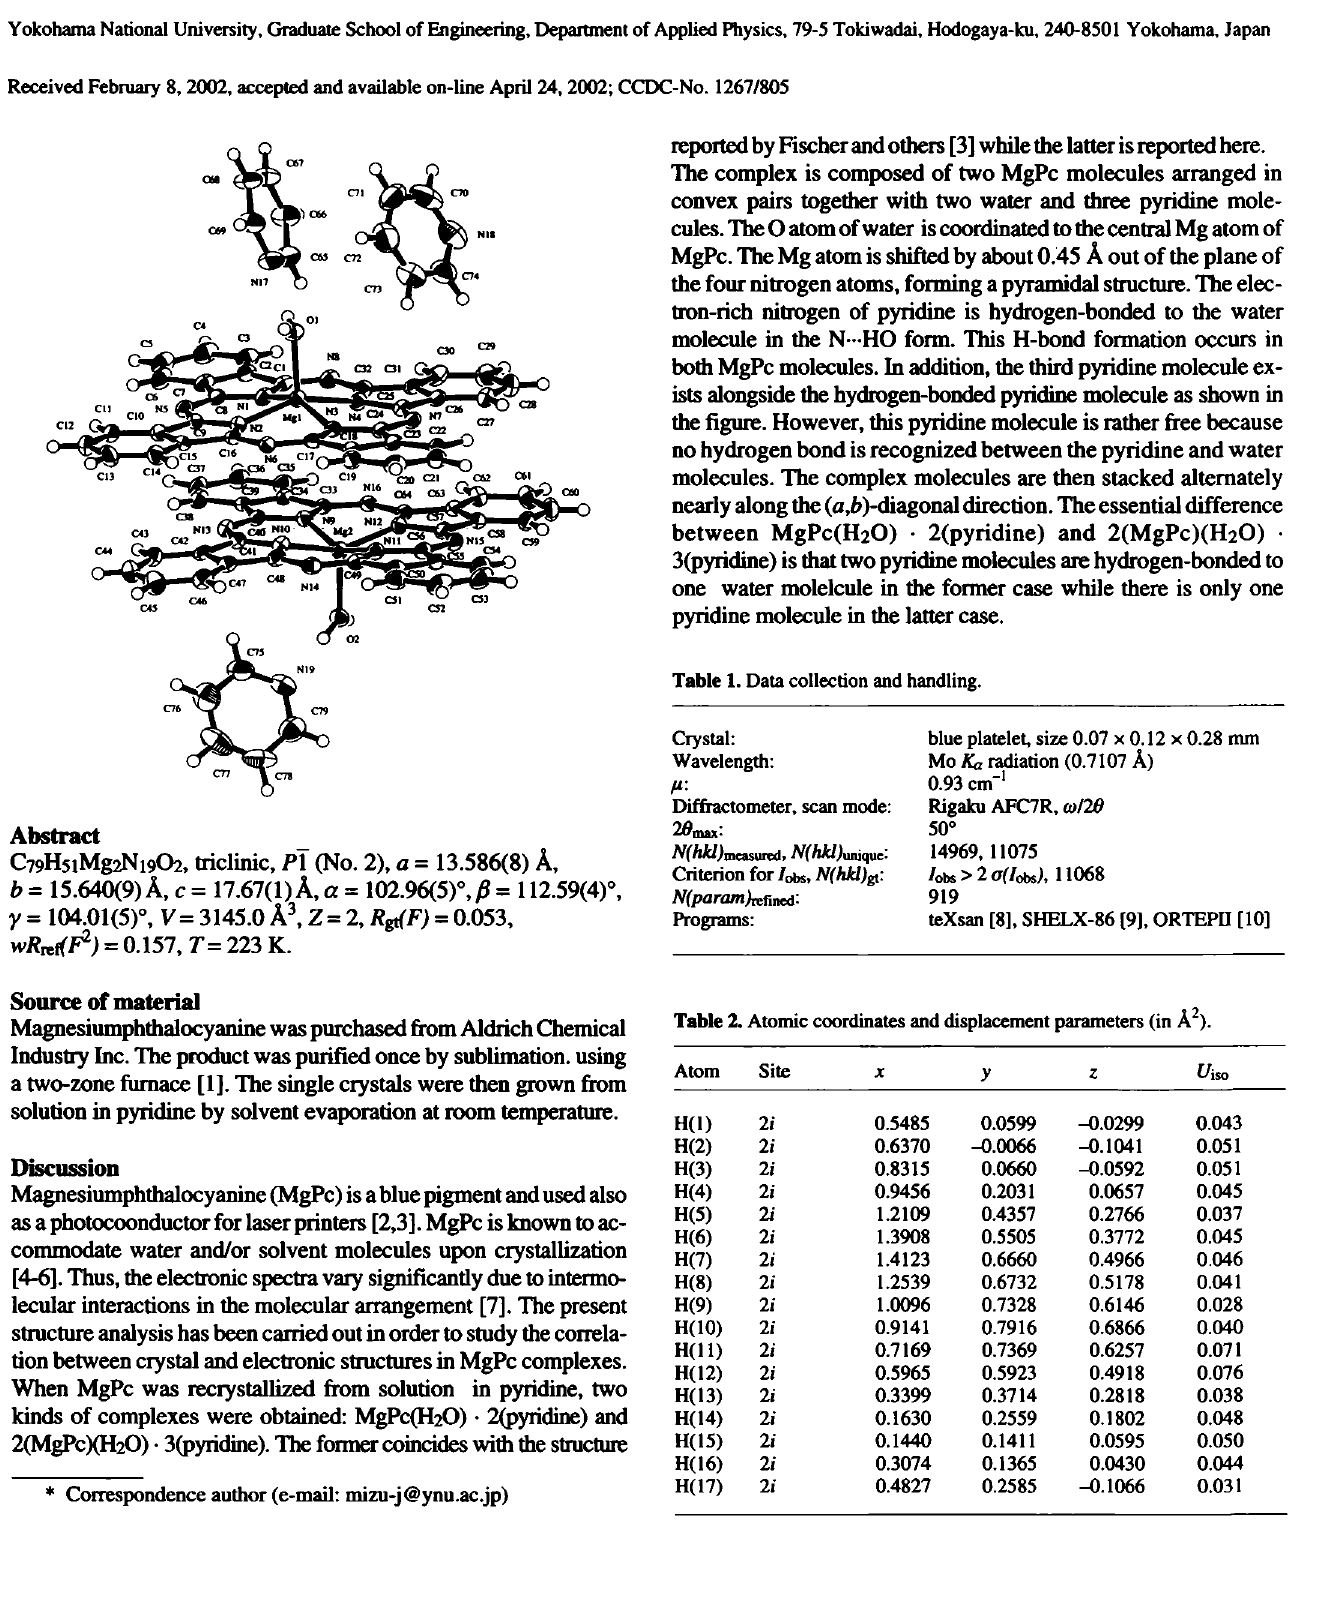
Table 2. Atomic coordinates and displacement parameters (in Â 2